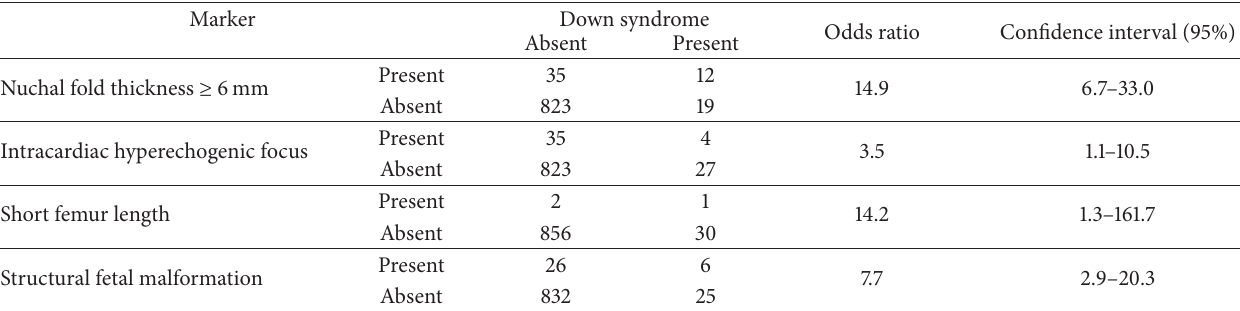
Table 4: Odds ratios for the ultrasound markers for Down